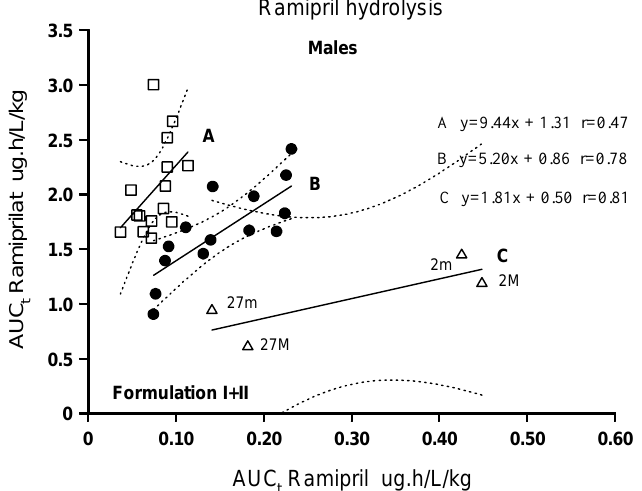
FIGURE 5. AUC t/ kg ramipril plotted vs. the AUC t /kg of the metabolite ramiprilat after the oral administration of 5 mg ramipril (Formulation I + II in males). Two apparent subgroups can be distinguished, each with a different slope of the regression line ( p < 0.0001) and with different Y- intercepts ( p = 0.0002). Subjects 2 and 27 hydrolyse ramipril very slowly (M first administration, m second administration).